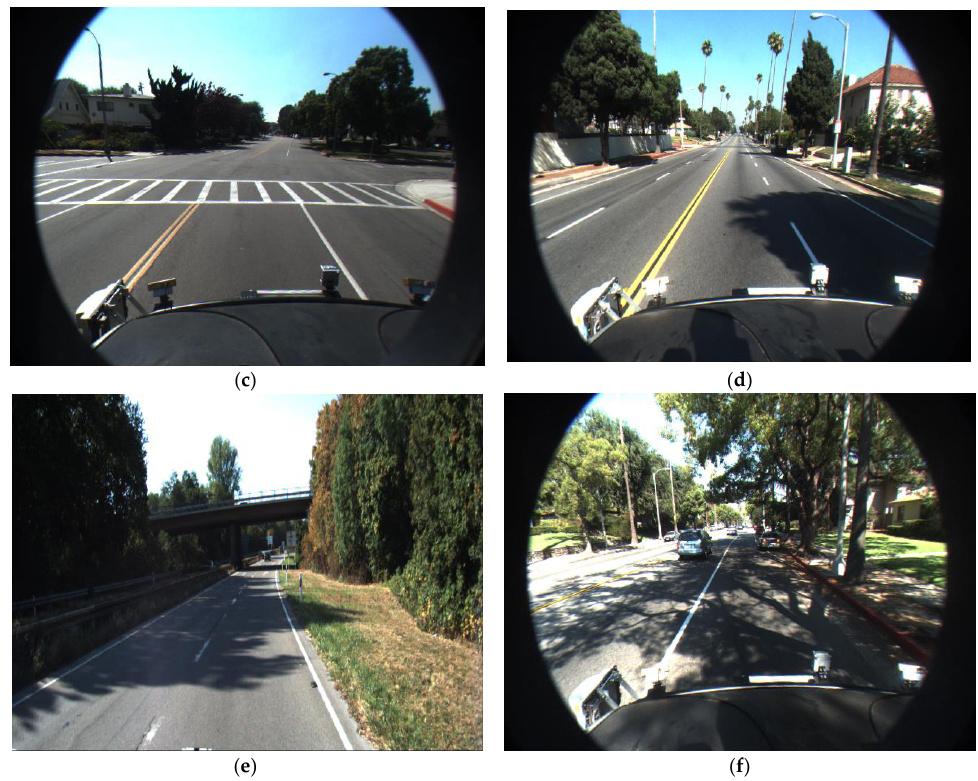
Figure 2. Examples of input images: ( a ) Image only with road lanes; ( b , c ) Images with other road markings; ( d , e , f ) Images with shadows.